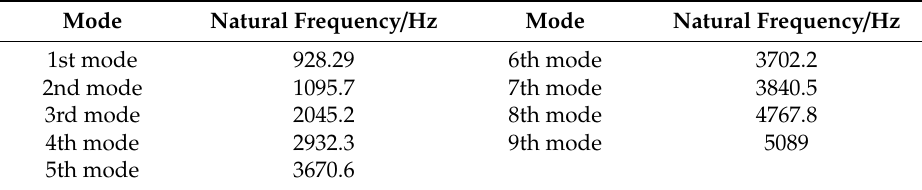
Table 2. Natural frequency of the pumps